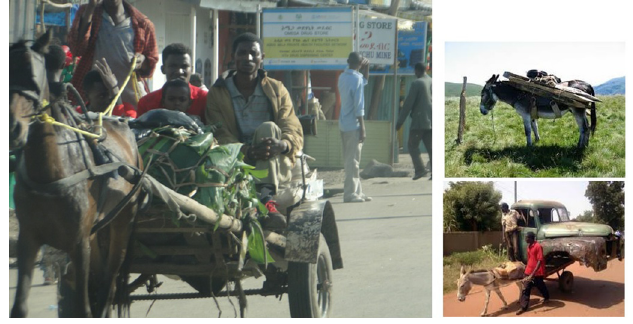
Fig. 1. Transport in some remote areas (photo J. Kenfack in